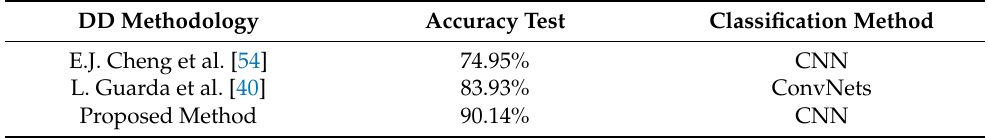
Table 12. Accuracy test comparison with related